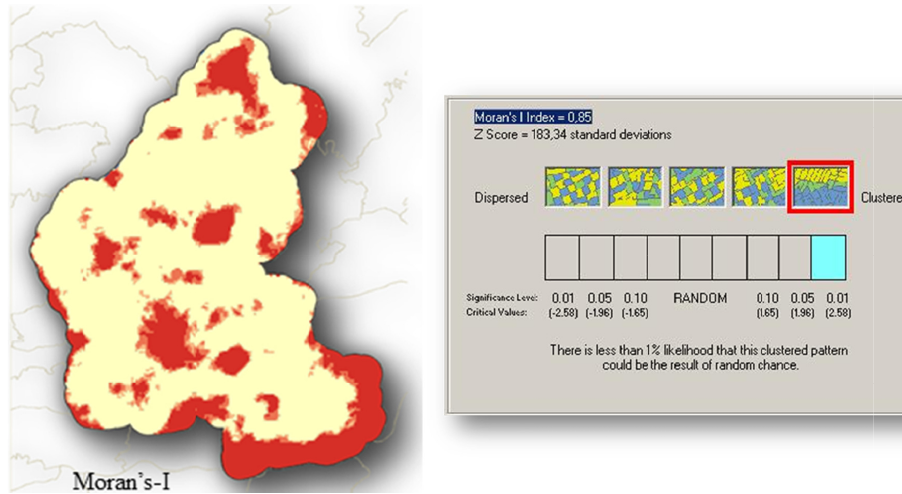
Fig. 5. Global spatial autocorrelation – Moran’s I results. 352